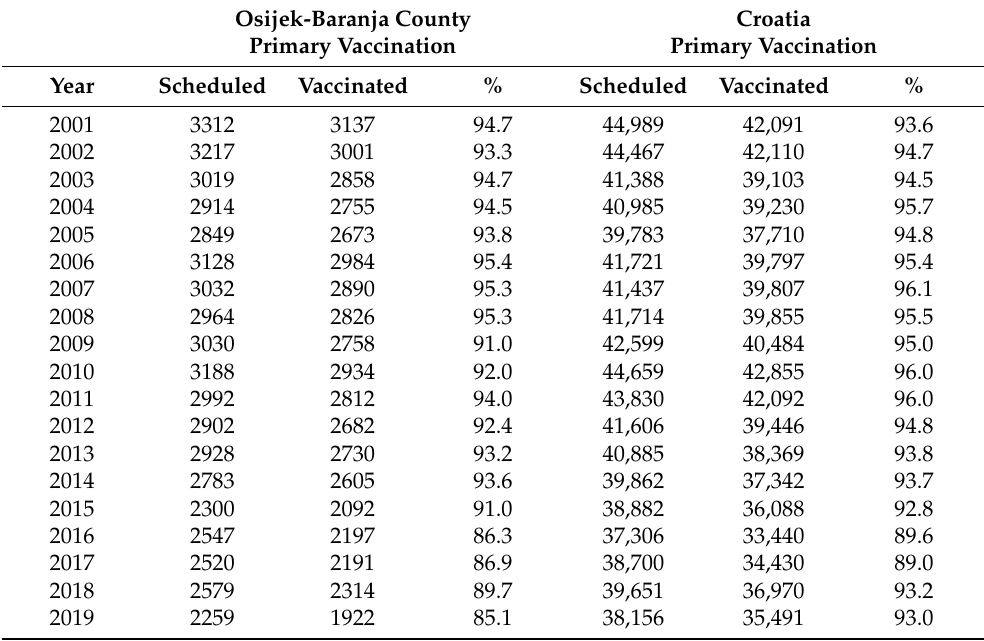
Table 1. Measles-containing vaccine primary vaccination in Osijek-Baranja County and Croatia from 2001 to 2019. Osijek-Baranja County